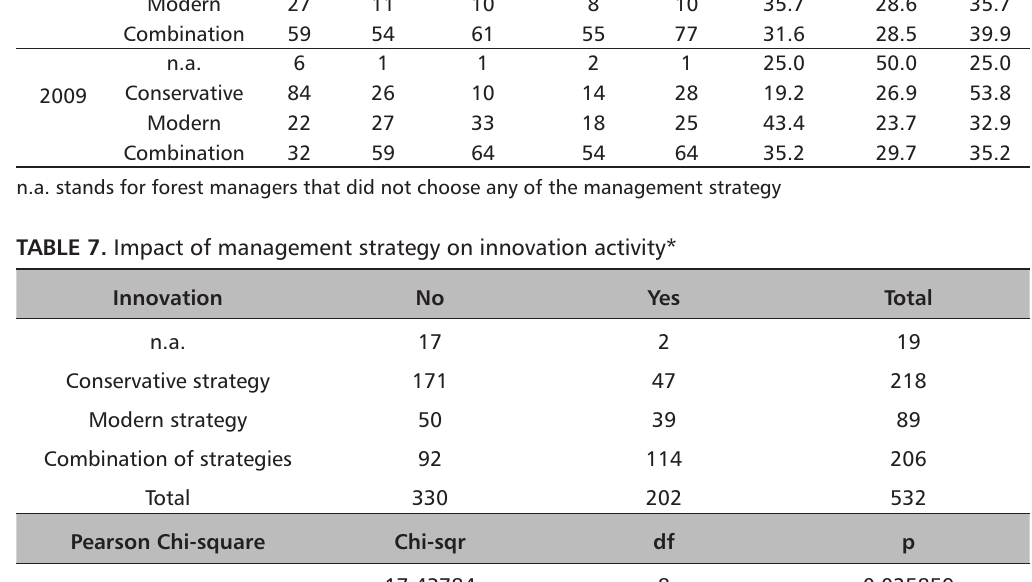
* presented data represent results from joined dataset (2002 and 2010 survey) n.a. stands for forest managers that did not choose any of the management